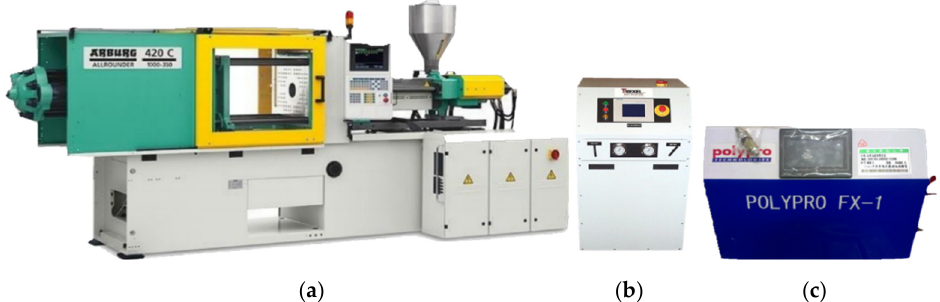
Figure 1. ( a ) Microcellular (MuCell) injection molding machine with a gas counter pressure equipment (ARBURG ALLROUNDER 420C). ( b ) Supercritical fluid (SCF) generator (Trexel). ( c ) High-frequency gas control valve.